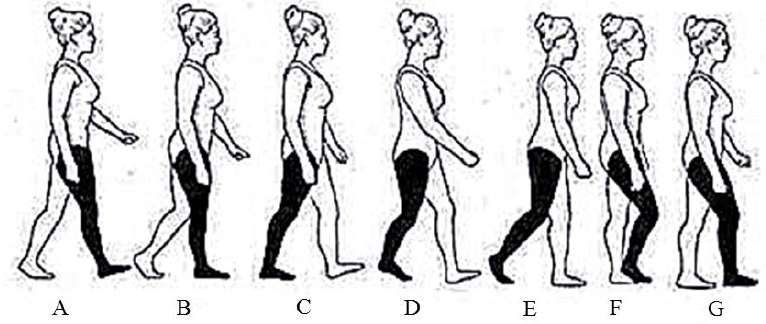
Figure 8. The seven stages of gait conversion process: ( A ) Foot strike, ( B ) opposite toe-off, ( C ) reversal of fore-aft shear, ( D ) opposite foot strike, ( E ) toe-off, ( F ) foot clearance, ( G ) tibia vertical.